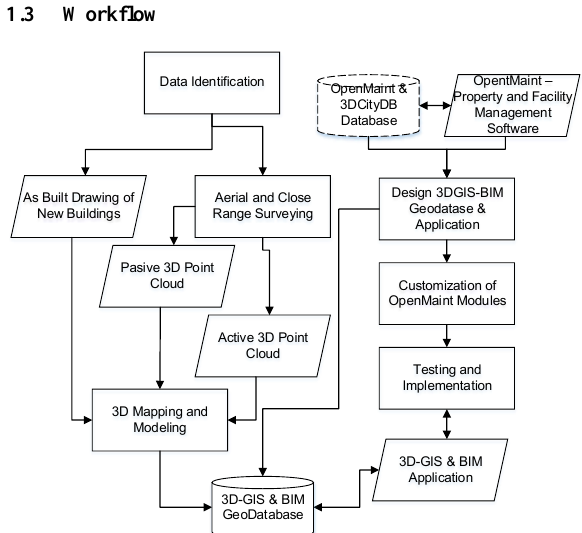
Figure 3. Workflow of developing geo-information system of ITB